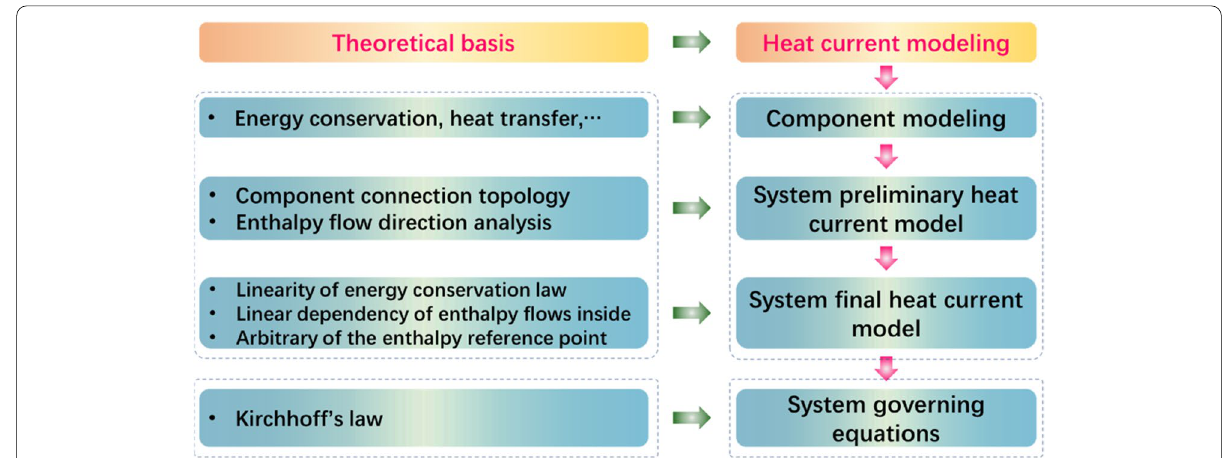
Fig. 10 Heat current modeling procedure